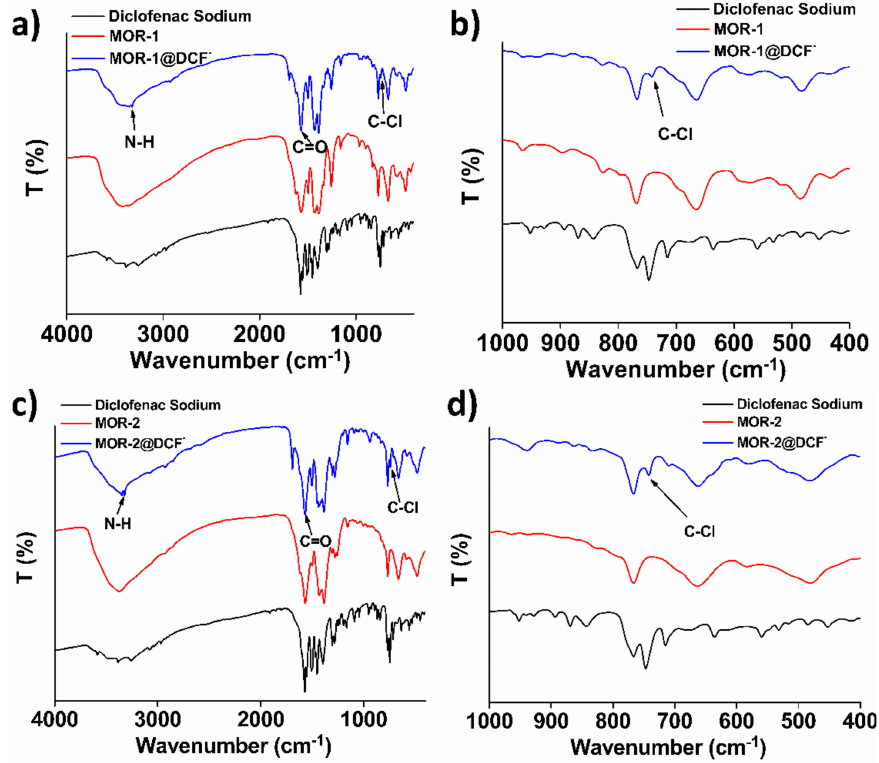
Figure 8. ATR-IR spectra of diclofenac sodium salt, ( a , b ) MOR-1 , MOR-1@DCF − , and ( c , d ) MOR-2 , MOR-2@DCF −